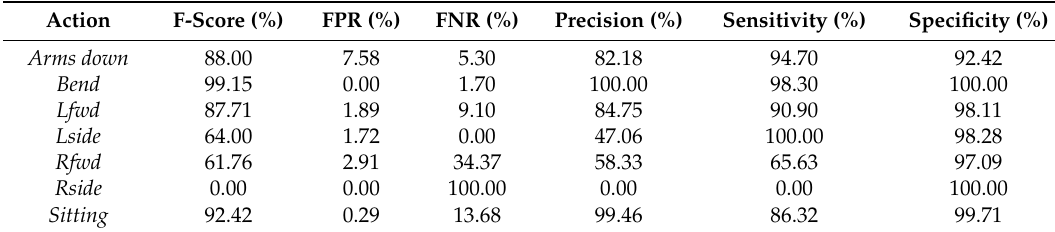
Table 6. Results for the predictions of the performed